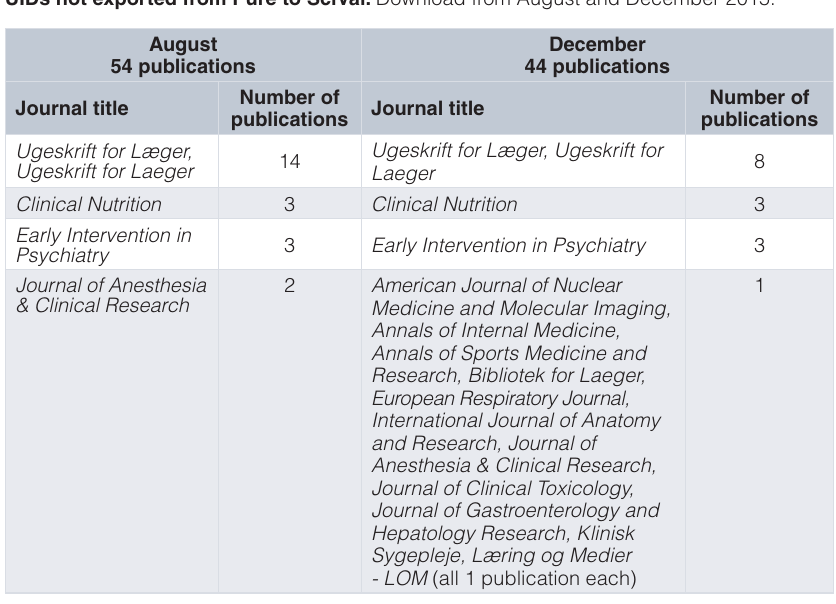
Table 7c. Top journals according to number of publications for publications without UIDs not exported from Pure to SciVal. Download from August and December